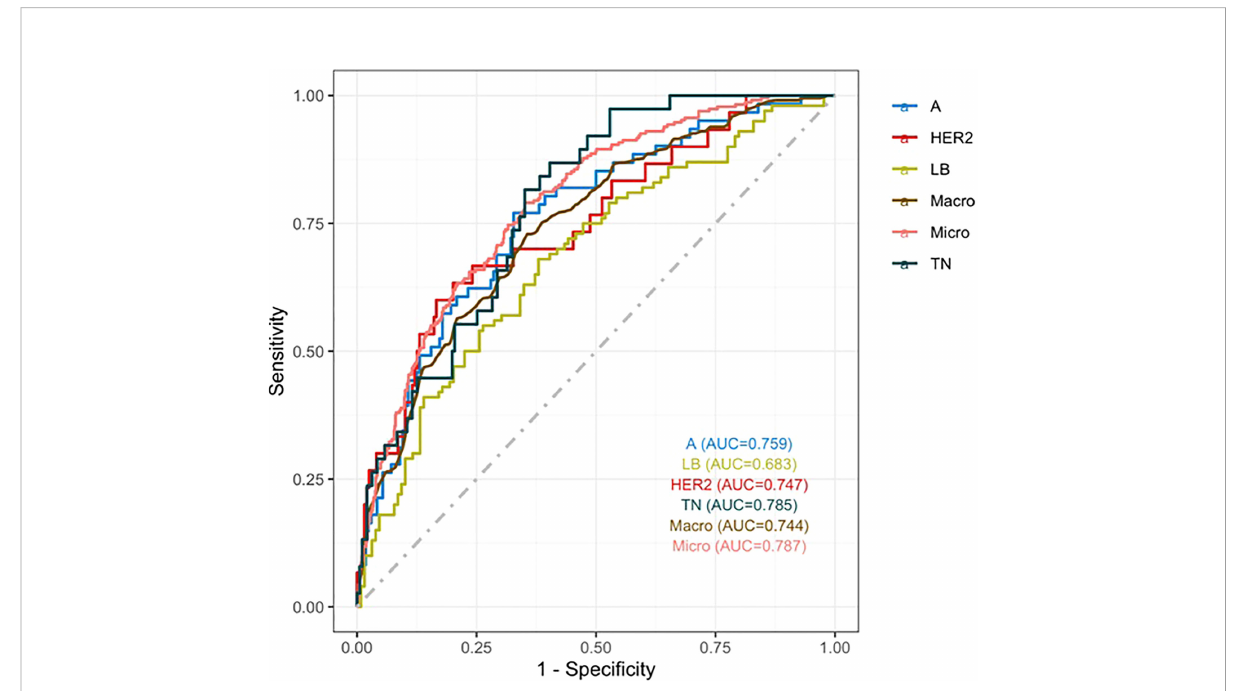
FIGURE 4 ROC curve. The macro- and micro-AUC were 0.744 and 0.787, respectively. The AUC was 0.759for predicting LA, 0.683 for predicting LB,0.747 for predicting HER2-positive, and 0.785 for predicting TN.